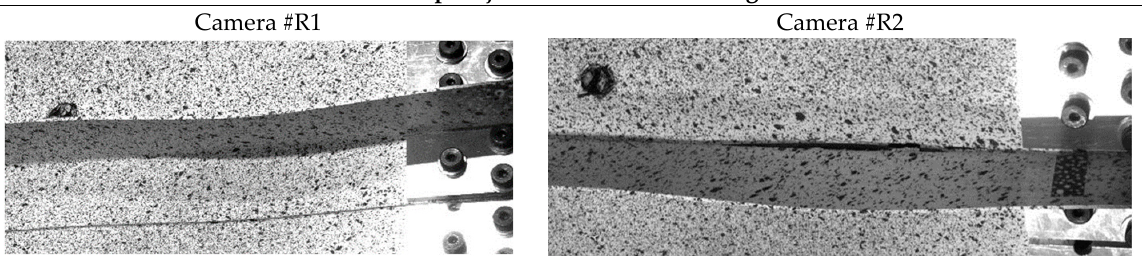
Figure 25. Zoomed observation of the first debonding of Sample3, from both sides of the stiffener.